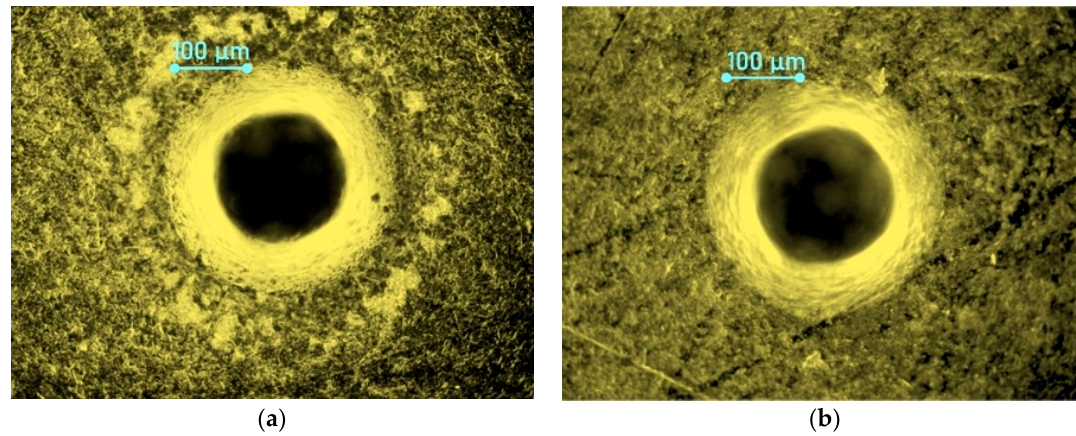
Figure 8. Rockwell indenter indentation area in the surface layer of 6WH10F hard alloy samples with DLCs: ( a ) coating without sublayer and ( b ) coating with sublayer (CrAlSi)N.